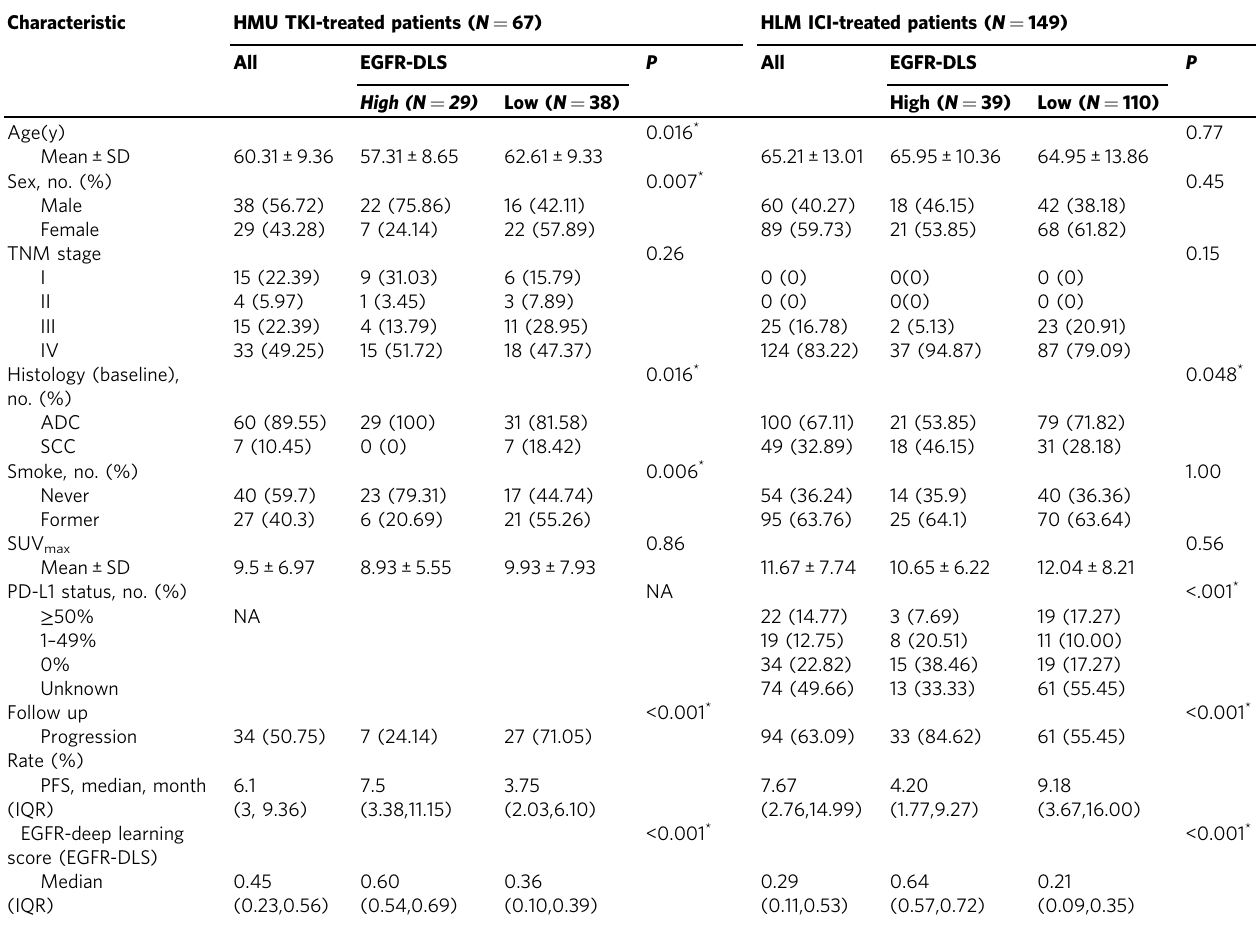
Table 2 Demographic and clinical characteristics for TKI-treated and ICI-treated patients.